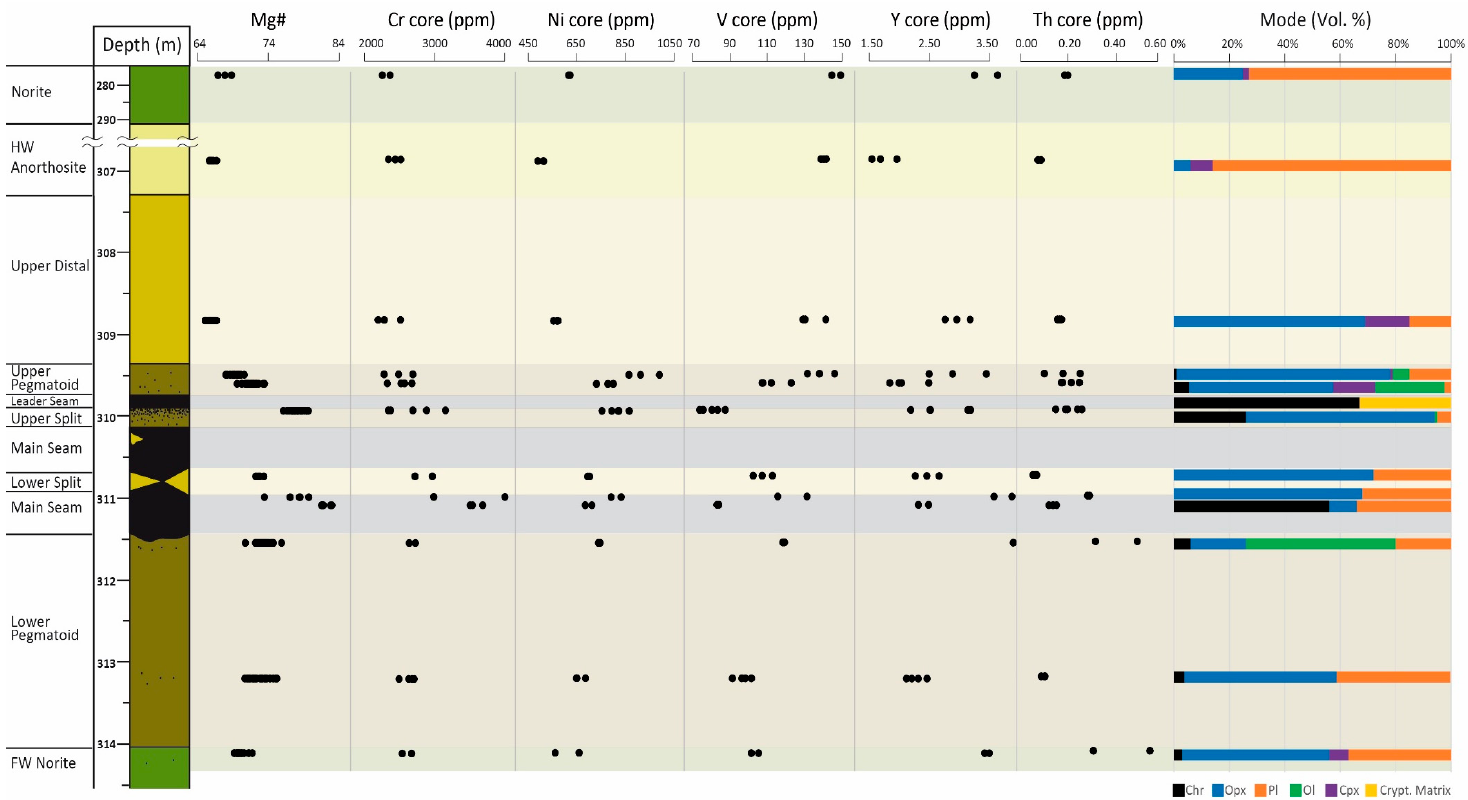
Figure 10. Chemostratigraphy of trace element concentrations extracted from orthopyroxene ‘core’ ROI, along with Mg#s and modal mineral abundances across the UG2 Unit, as well as its footwall and hangingwall in the studied drill core. Internal 2SE errors are within the symbol size. There are no chemical data for the Leader Seam because of the lack of orthopyroxene. Chr (chromite), Opx (orthopyroxene), Pl (plagioclase), Ol (olivine), Cpx (clinopyroxene), Crypt. Matrix (crypto-crystalline matrix).